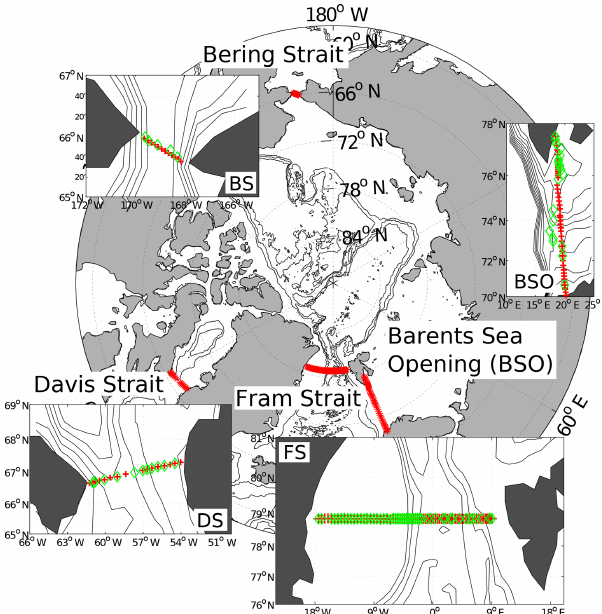
Figure 1. Map of the Arctic Ocean, showing the four main gate- ways. The position of the δ 18 O and nutrient sample locations is indicated by green diamonds, and the Tsubouchi et al. (2012) CTD station positions by red